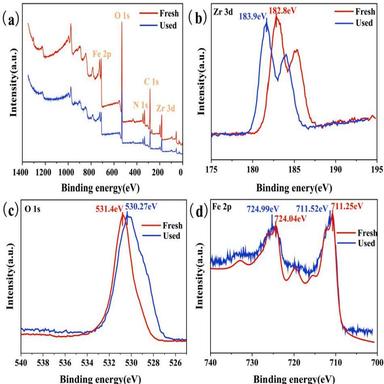
XPS spectra before and after photodegradation reaction: (a) survey scan, (b) Zr 3d (c) O 1s, and (d) Fe 2p.